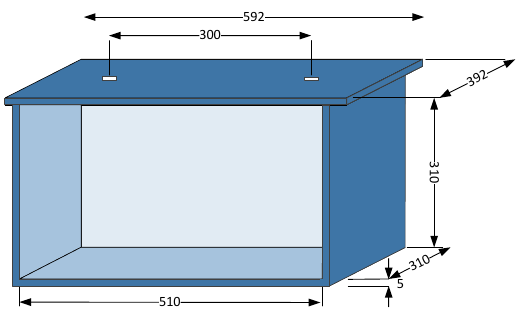
Figure 2. Dimensions of the tank, in